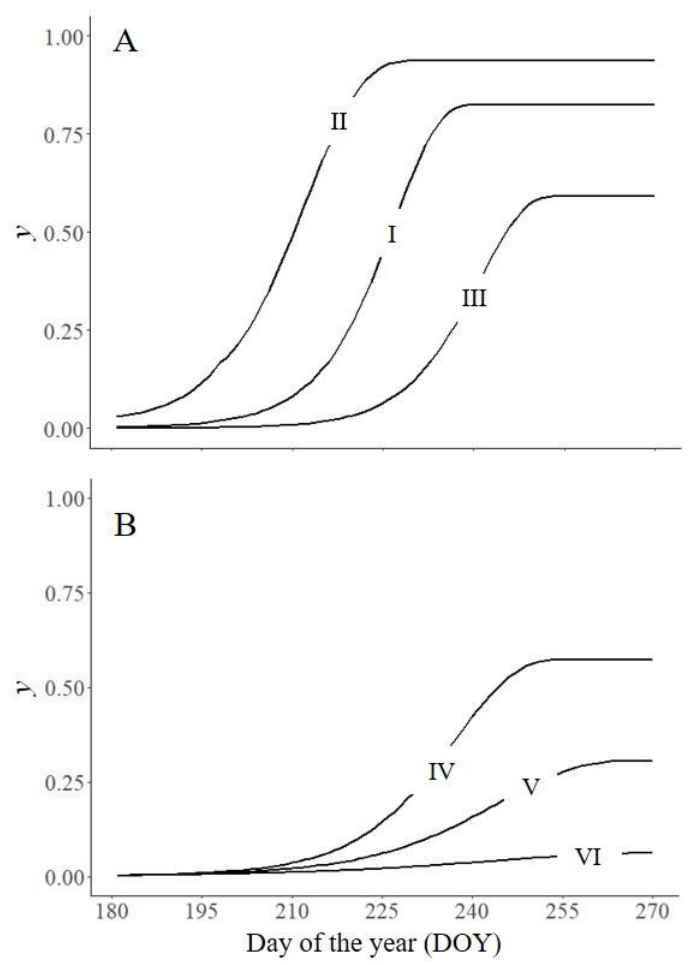
Figure 3. E ff ect of crop management actions that a ff ect either y (cid:48) 0 ( A ) or y (cid:48) ( B ) on disease intensity ( y ). I: Figure 3. Effect of crop management actions that affect either y’ 0 ( A ) or y’ ( B ) on disease intensity ( y ). untreated control, y 0 (cid:48) = 0.003, y (cid:48) as in Figure 2; II: y 0 (cid:48) = 0.03; III: y 0 (cid:48) = 0.0003; IV: y (cid:48) as in Figure 2 times I: untreated control, y 0 ’ = 0.003, y’ as in Figure 2; II: y 0 ’ = 0.03; III: y 0 ’ = 0.0003; IV: y’ as in Figure 2 times 0.67; V: y (cid:48) as in Figure 2 times 0.5; and VI: y (cid:48) as in Figure 2 times 0.33. Symbols are listed in Table 0.67; V: y’ as in Figure 2 times 0.5; and VI: y’ as in Figure 2 times 0.33. Symbols are listed in Table 1.